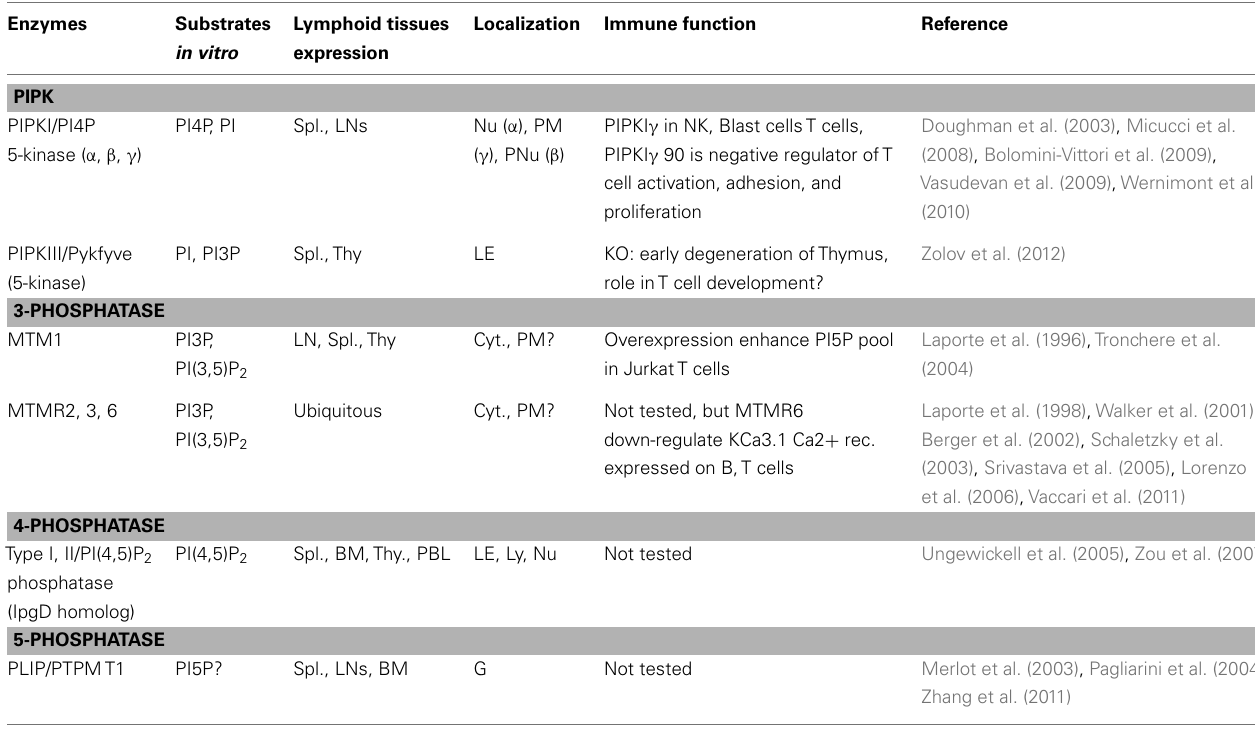
Table 1 | Enzyme expression, localization, and functions in lymphoid